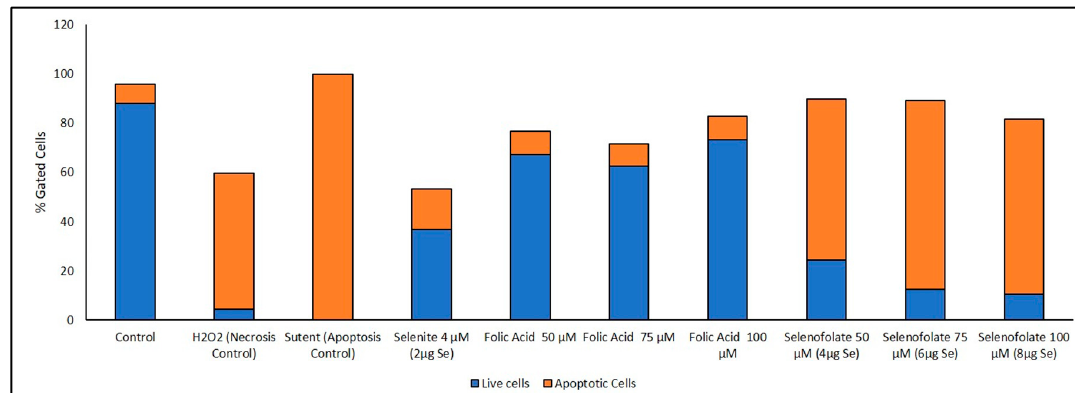
Figure 10. Graphical representation (as percent of cells) of apoptotic events following Selenofolate treatment. Percent distribution of MDA-MB-468 apoptotic cells after treatment with H 2 O 2 (necrosis inducer), Sutent (apoptosis inducer), selenite (positive control), Folic Acid and Selenofolate treatments, or untreated. Data are expressed as the mean ( n = 3) and is based upon 100% of cells gated.